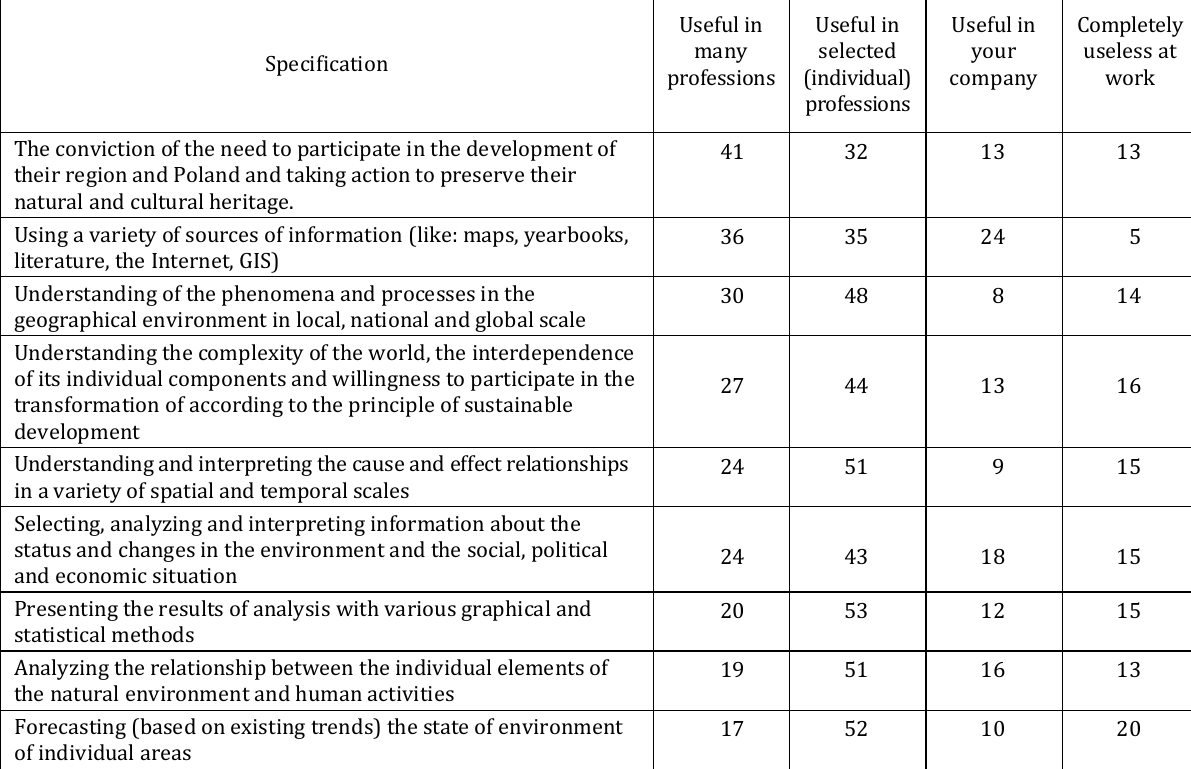
Table 2. Which of the competences might be useful in professional work? (in %)